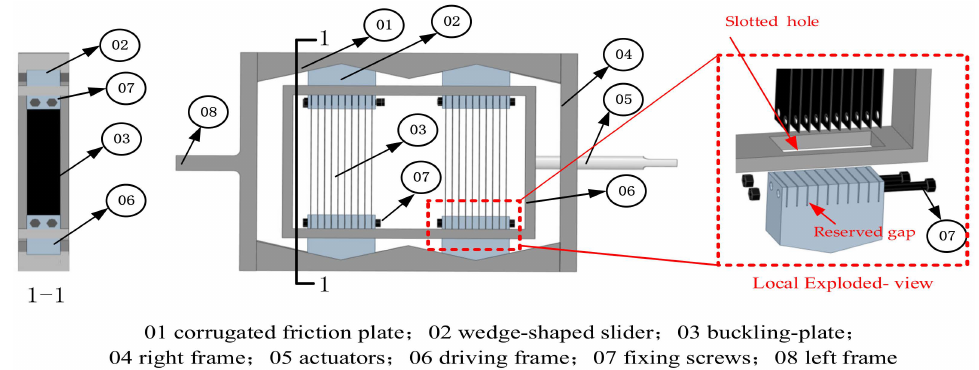
Figure 1. Configuration of